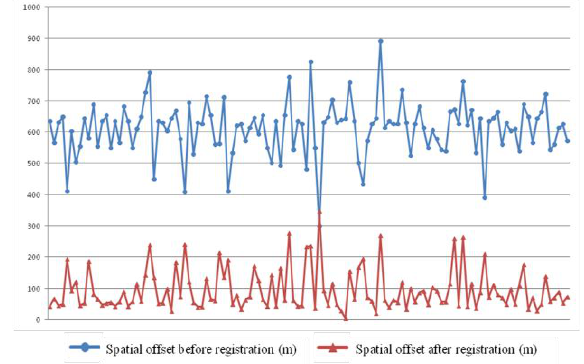
Figure 2. Spatial offsets before and after registration Mean value (m) Standard deviation (m)